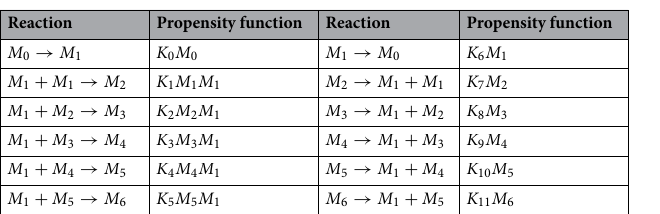
Reaction Propensity function